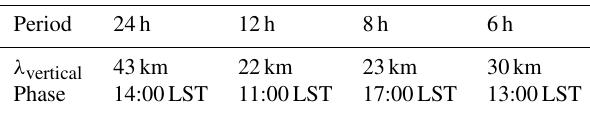
Figure 5. Comparison of the temperature variations measured with the Fe lidar (blue) at an altitude of 86km with the reconstruction (magenta) using the results of the harmonic wave analysis. The am- plitudes of the 24, 12, 8, and 6h components are 4.8, 2.8, 6.5, and 1.4K. Table 1. Vertical wavelengths ( λ vertical ) and phases (at 86km) de- rived from the harmonic fit of Fe lidar